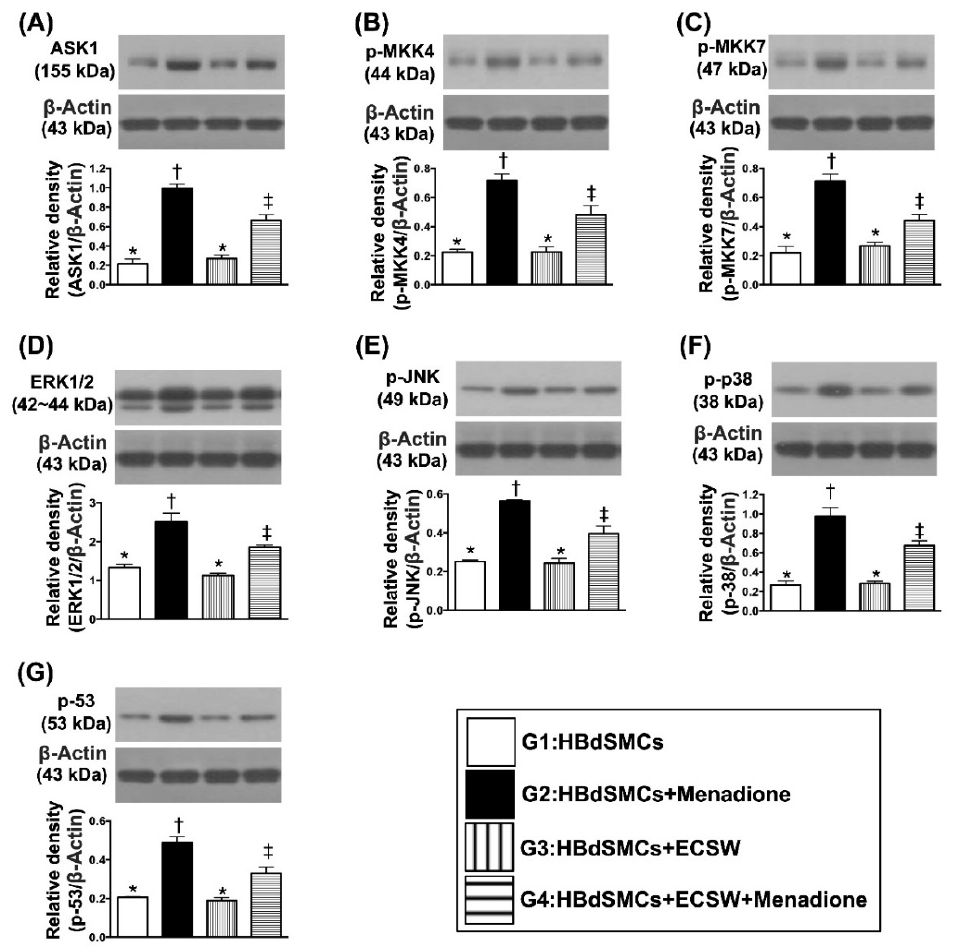
Figure 3. ECSW therapy regulated the cell-stress signaling in RBdSMCs. ( A ) Protein expression of Apoptosis signal-regulating kinase 1 (ASK1), * vs. other groups with different symbols (†, ‡), p < 0.001. ( B ) Protein expression of phosphorylated Mitogen-activated protein kinase kinase 4 (p-MKK4), * vs. other groups with different symbols (†, ‡), p < 0.001. ( C ) Protein expression of p-MKK7, * vs. other groups with different symbols (†, ‡), p < 0.001. ( D ) Protein expression of ERK1/2, * vs. other groups with different symbols (†, ‡), p < 0.001. ( E ) Protein expression of phosphorylated c-Jun N-terminal kinases (p-JNK), * vs. other groups with different symbols (†, ‡), p < 0.001. ( F ) Protein expression of p-p38, * vs. other groups with different symbols (†, ‡), p < 0.001. ( G ) Protein expression of p-53, * vs. other groups with different symbols (†, ‡), p < 0.001. All statistical analyses were performed by one-way ANOVA, followed by Bonferroni multiple comparison post hoc test ( n = 6 for each group). Symbols (*, †, ‡) indicate significance (at 0.05 level). ECSW = extracorporeal shock wave; RBdSMCs = rat bladder smooth muscle cells.